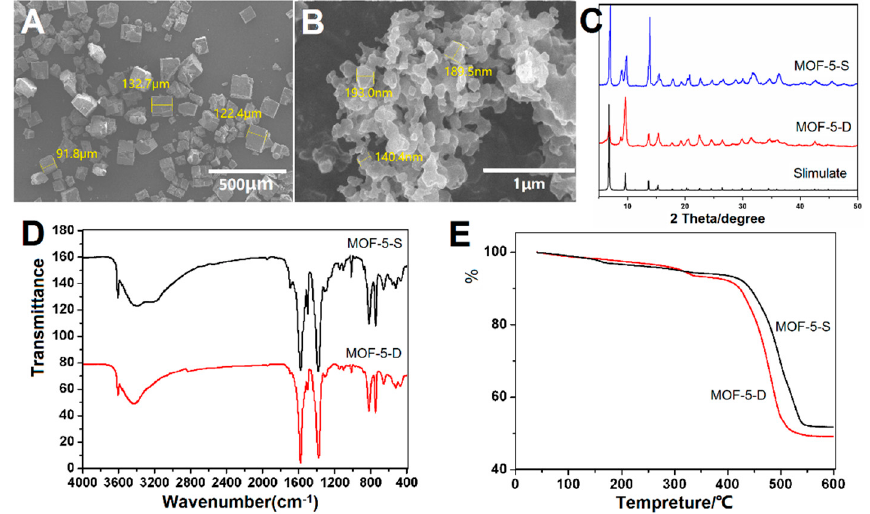
Figure 4. Characterization of MOF-5 synthesized by two methods: ( A ) Scanning Electron Microscopy (SEM) Image of MOF-5-S; ( B ) SEM Image of MOF-5-D; ( C ) X-ray diffraction (XRD) patterns of MOF-5-S and MOF-5-D ( D ) Fourier Transform Infrared Spectrometer (FTIR) spectra of MOF-5-S and MOF-5-D; ( E ) Thermogravimetric (TG) analysis of MOF-5-S and MOF-5-D.